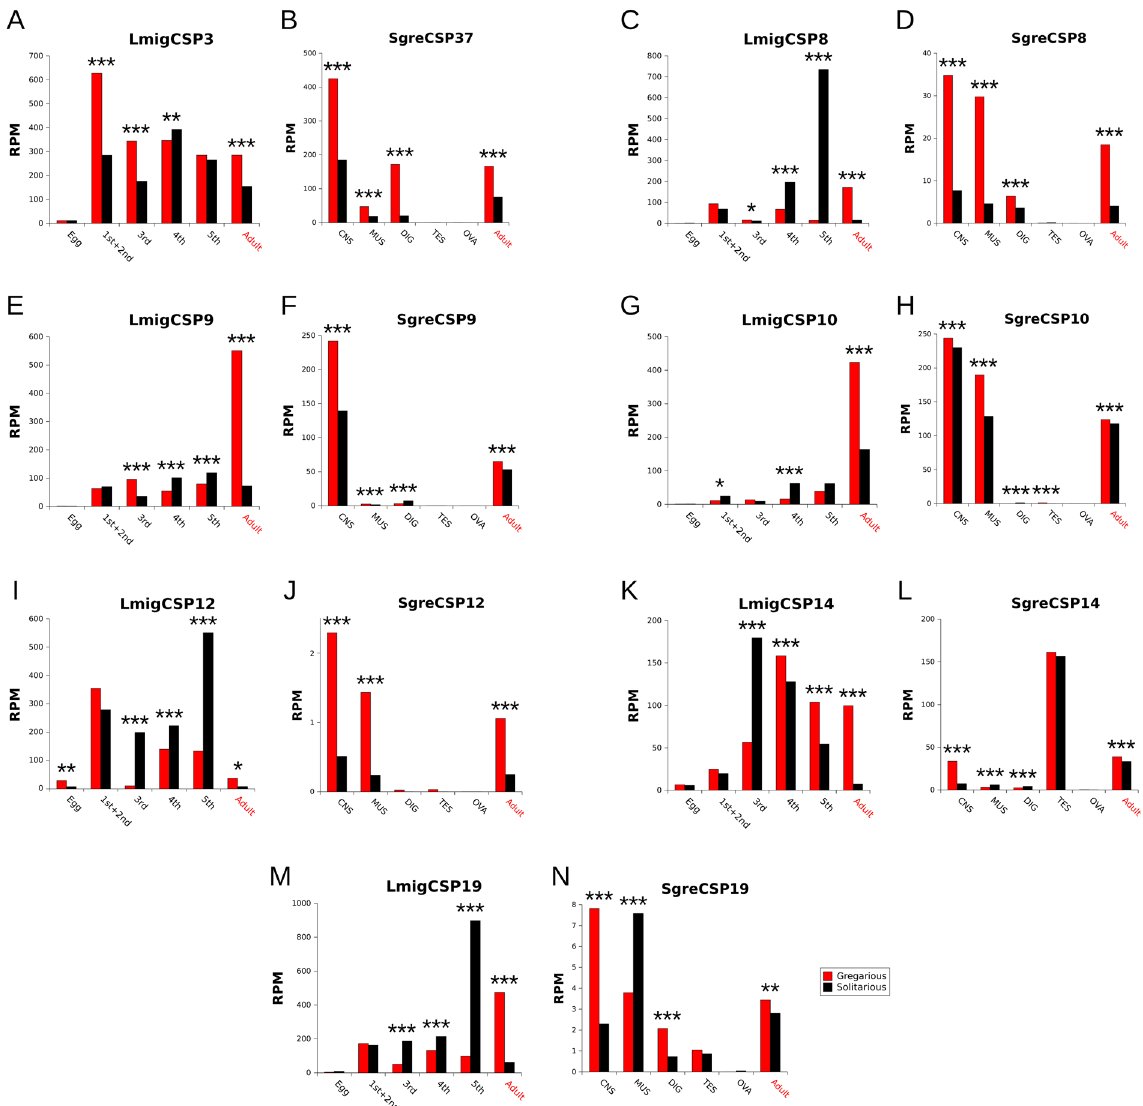
Figure 3. Tissue and developmental stage-specific details of the gregarious (red bars) and solitarious (black bars) expression profiles of the seven orthologous S . gregaria and L . migratoria CSP pairs that show higher expression in gregarious adult locusts in general (red text in the X axes). The Y axes represent the NGS reads mapped to the CSP per million of total mapped reads (RPM). Note that the scales of the Y axes are adapted to the expression level of each CSP. The data for orthologous pairs are in consecutive figures (( A – D ) etc.)—note that LmigCSP3 is homologous to SgreCSP37 . The X axes in ( A , C , E , G , I , K , M ) show the analyzed developmental stages of L . migratoria , including eggs, adults with no digestive tube (see Methods) and nymphal instars (1st + 2nd = first and second instars, 3rd = third instar, 4th = fourth instar, 5 th = fifth instar). The X axes in ( B , D , F , H , J , L , N ) show the tissues analyzed for S . gregaria (CNS = central nervous system, MUS = muscle, DIG = digestive tube, OVA = ovaries, TES = testicles)—the data for adults in this case were the merge of the data from all the tissues but the digestive tube. The asterisks indicate the significance level of the test on normalized fold change (see Methods) after FDR correction ( * 0.05–0.01; ** 0.01–0.001 and ***